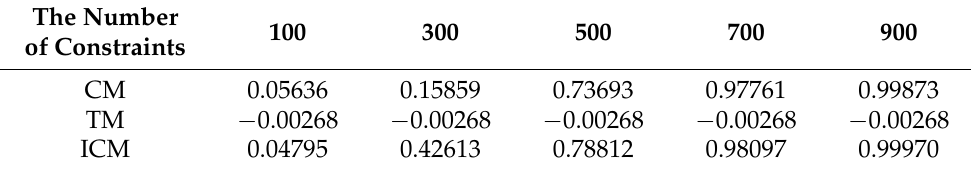
Table 4. Comparison of Adjusted Rand Index on dataset